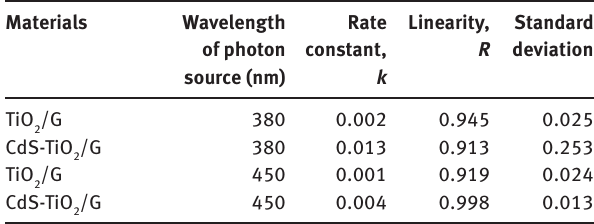
(mol/s), and the photon